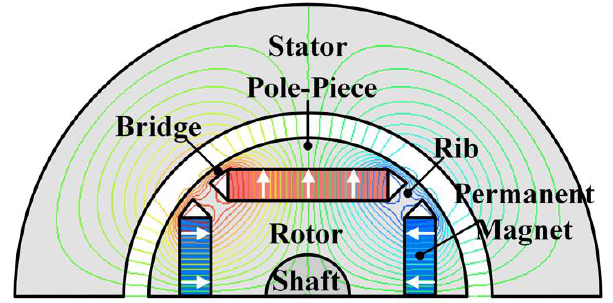
Figure 3. The shape of analysis model with assumptions. Figure 2. The shape of analysis model.